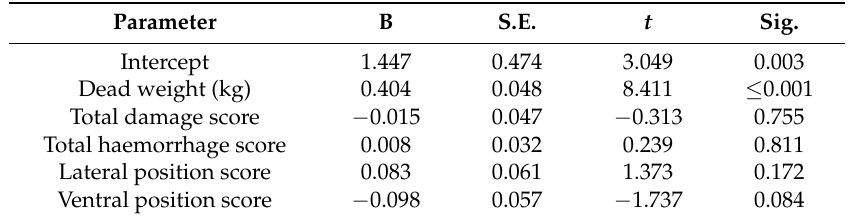
Table 3. Parameter estimates from the GLM testing for an effect of dead weight (kg), total damage score, total haemorrhage score, and lateral and ventral shot position scores on movement score.